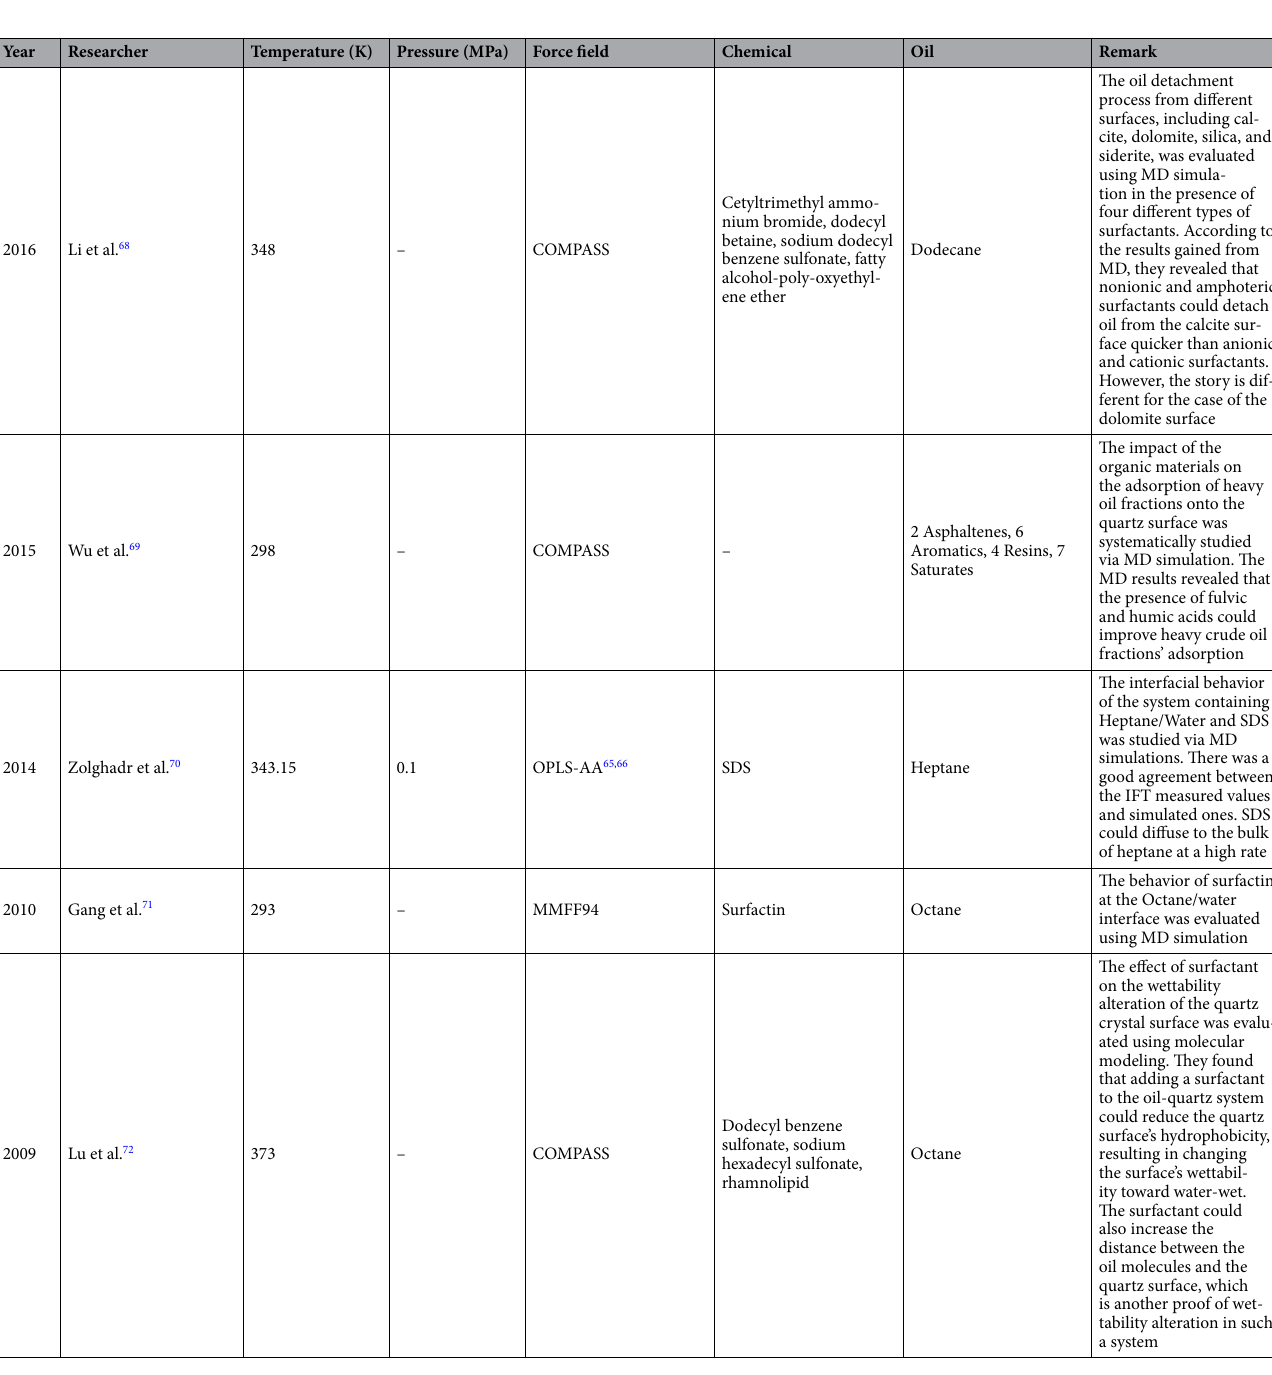
Table 1. Summary of MD studies for oil systems with/without